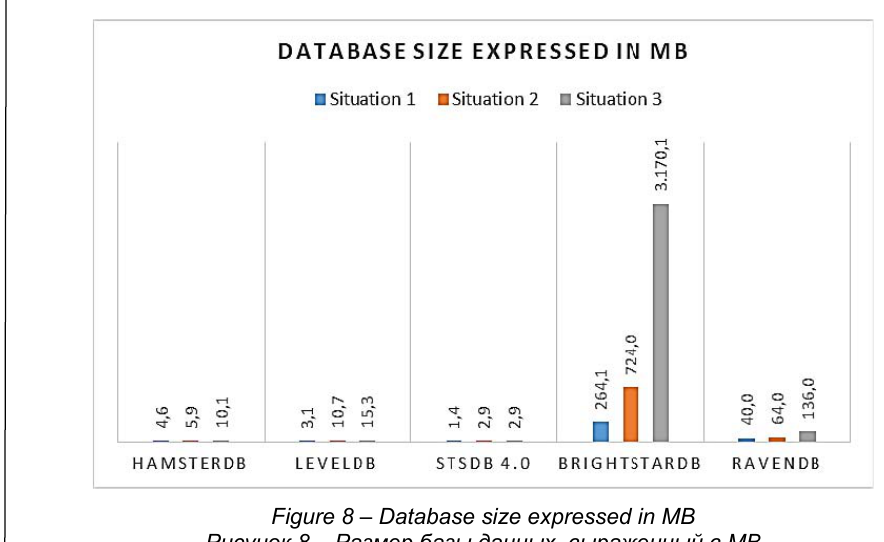
Figure 8 – Database size expressed in MB Рисунок 8 – Размер базы данных , выраженный в MB Слика 8 – Величина база података изражена у